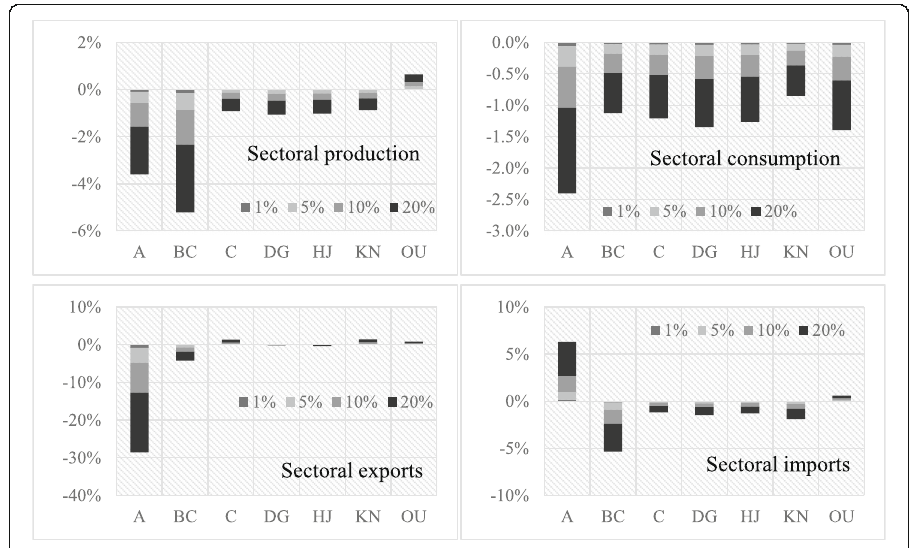
Fig. 9 Simulated sectoral effects of tax on use of nitrogen fertilizers (products of chemical industry) in agricultural production. (Source: authors calculations based on CGE model simulations results)